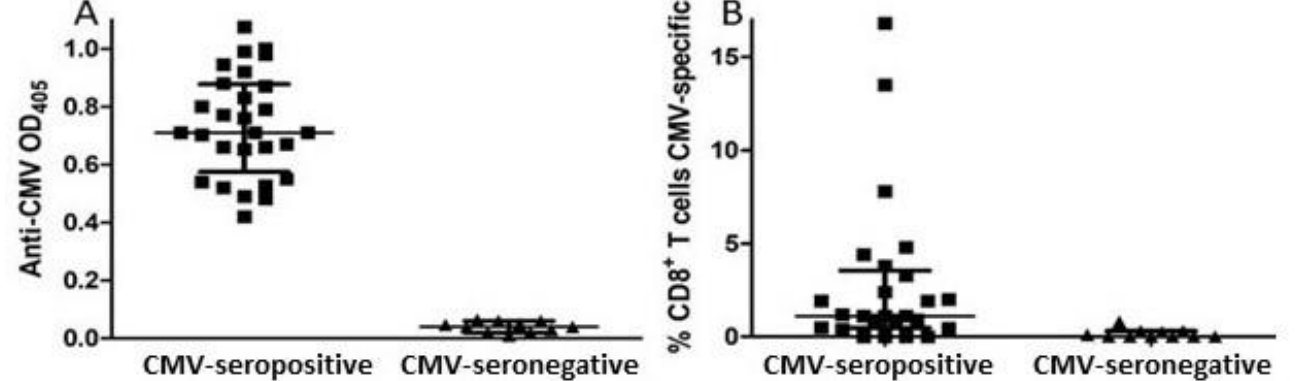
Figure 1. Humoral and CD8 + T cell responses against CMV in study participants. ( A ) The presence of IgG antibodies against CMV was assessed by semi-quantitative ELISA with plasma collected at time of entry. ( B ) PBMC were tested for CD8 + T cell responses against peptide pools spanning CMV pp65 and IE-1 proteins by intracellular flow cytometry detecting IFN- γ . Error bars on graphs show median ± interquartile range for each group.